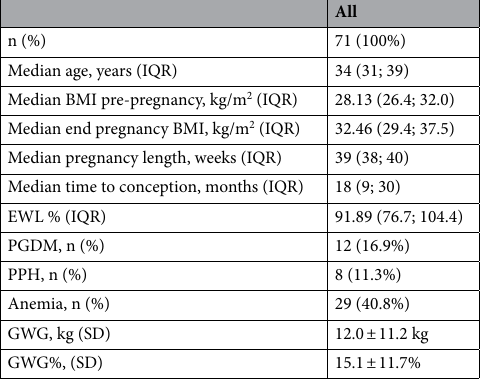
Table 1. Basic characteristics of the study population. BMI body mass index, EWL% excess weight loss, PGDM pre-pregnancy diabetes mellitus, PPH pre-pregnancy hypertension, SD standard deviation,